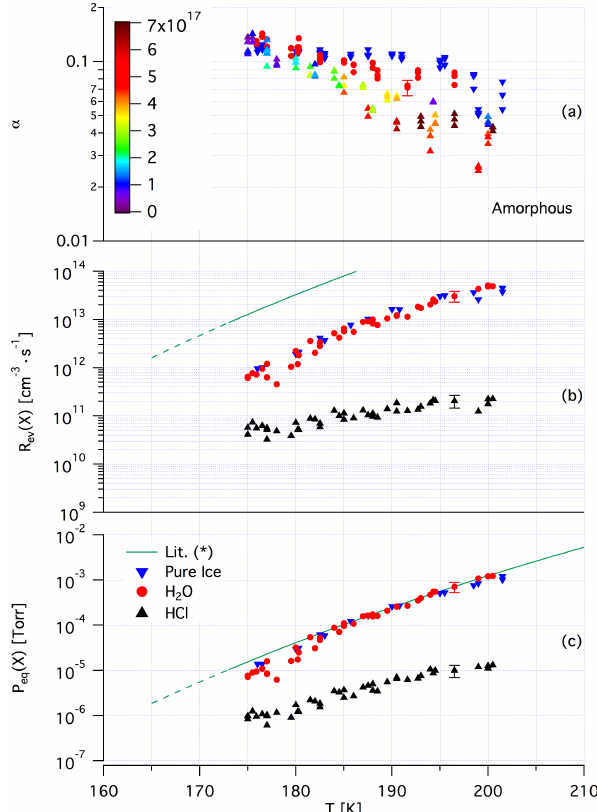
Figure 3: Synopsis of kinetic results for amHCl using H 2 O, HCl as a probe gas. The 1204 Figure 3. Synopsis of kinetic results for amHCl using H 2 O, HCl as symbols used are explained in the text. The calculated relative error for α is 10%. The 1205 a probe gas. The symbols used are explained in the text. The cal- culated relative error for α is 10%. The relative errors calculated relative errors calculated for R ev (HCl) and P eq (HCl) are 30% whereas for R ev (H 2 O) 1206 for R ev (HCl) and P eq (HCl) are 30%, whereas for R ev (H 2 O) and and P eq (H 2 O) they are 25%. Examples of the amplitude of the errors are reported for 1207 P eq (H 2 O) they are 25%. Examples of the amplitude of the errors selected points. The green line shows results from Marti and Mauersberger, 1993. The 1208 are reported for selected points. The green line shows results from colour scale shows the cumulative adsorbed dose after HCl pulsed gas admission. 1209 Marti and Mauersberger (1993). The colour scale shows the cumu- 1210 lative adsorbed dose after HCl pulsed gas